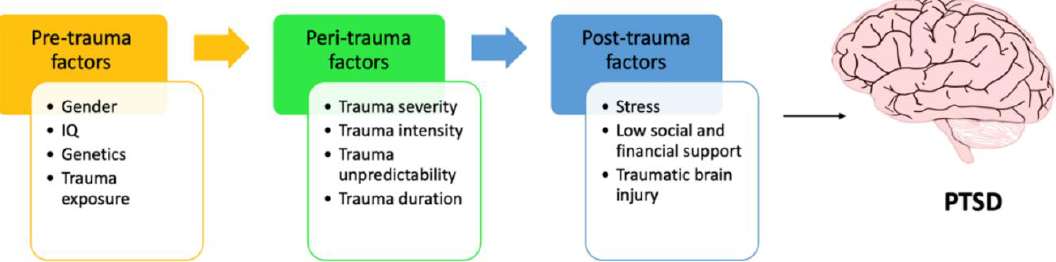
Figure 1. Trauma factors associated with post-traumatic stress disorder (PTSD). Pre-trauma factors include gender, IQ, family history, and various neurobiological factors while peri-trauma factors include the type and duration of trauma exposure. Finally, post-trauma factors include social support factors, coping skills, and cognitive flexibility.